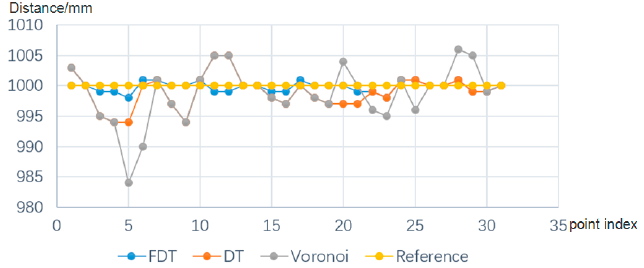
Figure 7. Result of skeletonization base on FDT. ( a ) The original image; ( b ) the FDT image; ( c ) the extracted skeleton of light stripe.